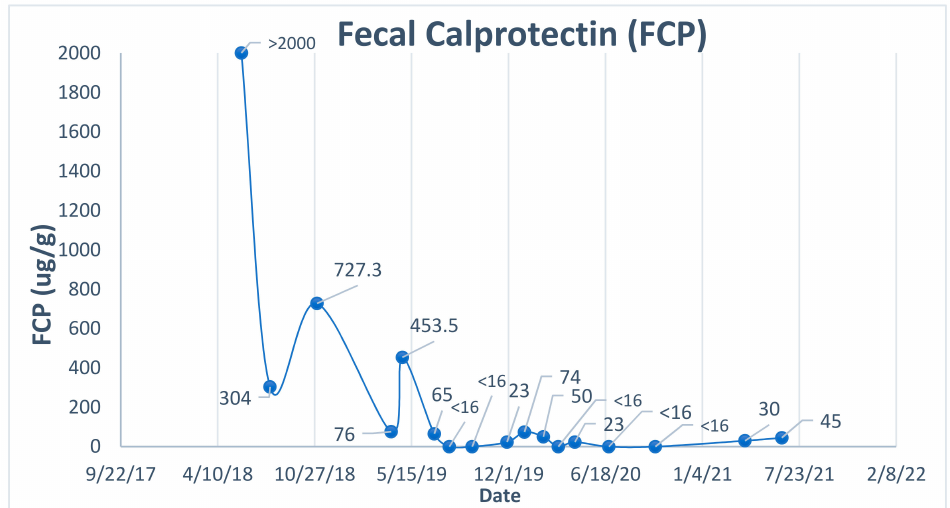
Figure 1. Fecal Calprotectin Results (10 April 2018–17 June